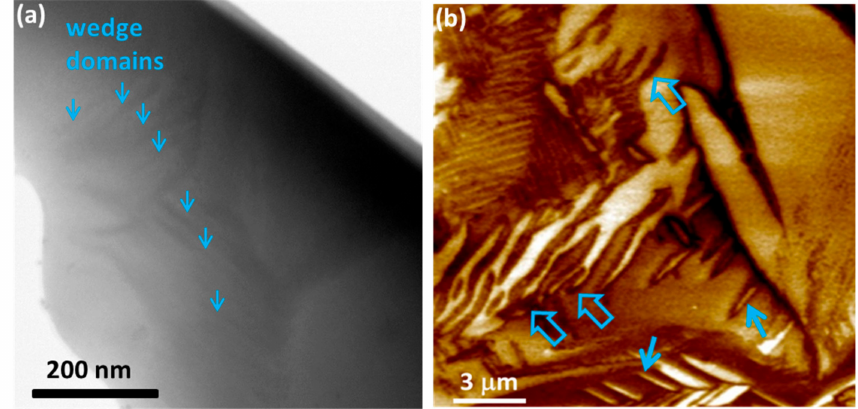
Figure 3. ( a ) Scanning–transmission electron microscope (STEM) image and ( b ) PFM out-of-plane amplitude image (drive AC signal: 6 V, 350 kHz) showing wedge domains. In ( b ), the domains with straight and curved domain walls (DWs) are marked with solid and thick open arrows,